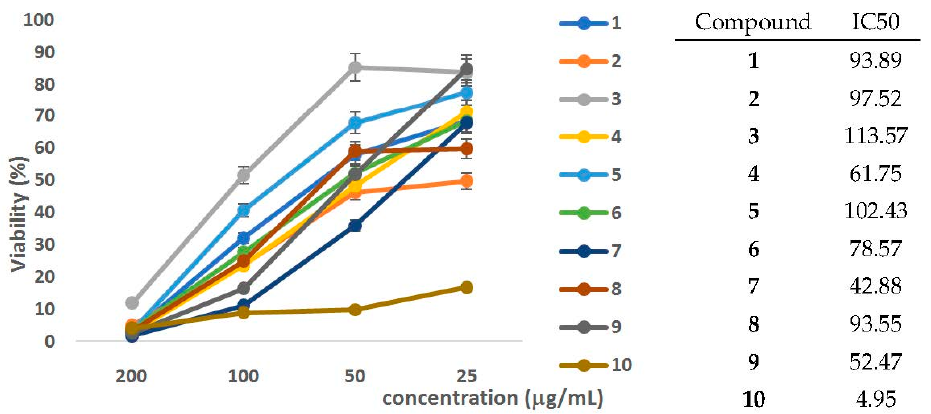
Figure 3. Graphical representation of cell viability percentage vs. concentration for compounds 1 – 10 (left); IC 50 values (right). ( left ); IC 50 values ( right